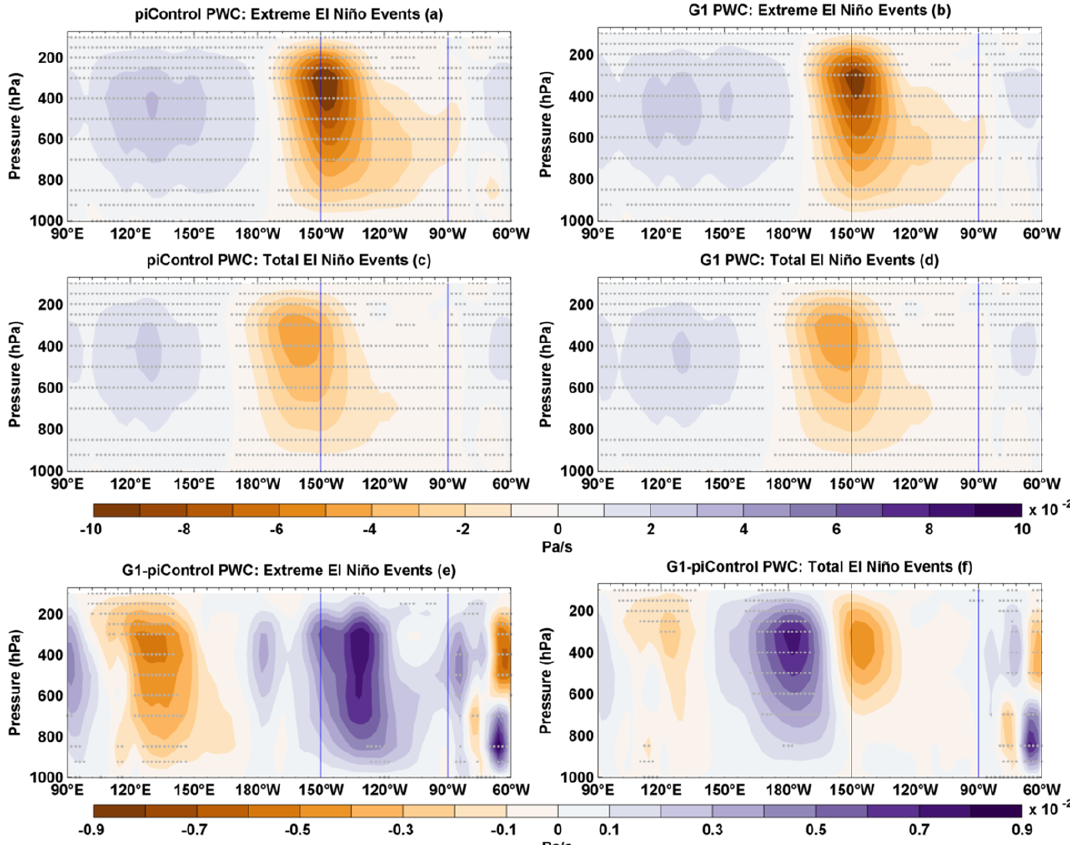
Figure 11. Composites of PWC anomalies for extreme El Niño events in (a) piControl and (b) G1. Composites of PWC anomalies for the total number of El Niño events in (c) piControl and (d) G1. Composite differences (G1 − piControl) of PWC for (e) extreme El Niño events and (f) total number of El Niño events. Stipples indicate grid points with statistical significance at 99%cl using a non-parametric Wilcoxon rank-sum test. The vertical blue lines indicate the Niño3